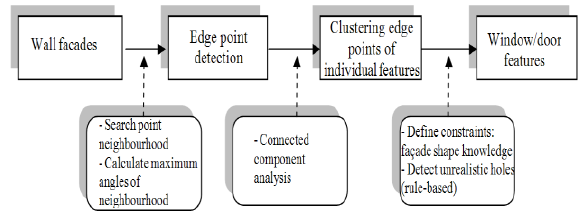
Figure 1: Workflow of façade object detection